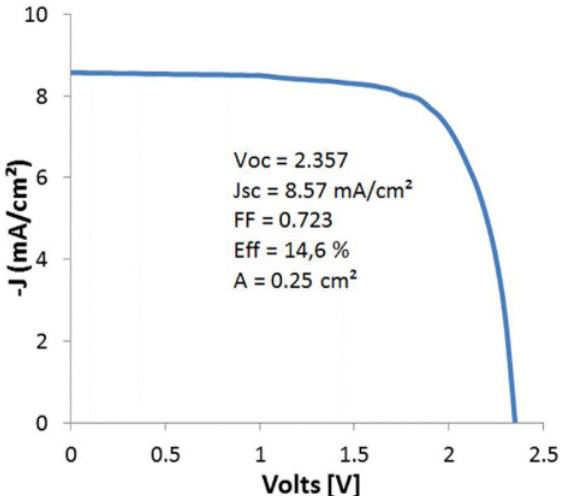
Fig. 3. Initial AM1.5 current-voltage (J-V) characteristics of triple-junction a-Si:H (a-Si:H/a-SiGe:H/a-SiGe:H) solar cell with 14.6% efficiency (adapted from [10]). Note: More recent cell records for the same technology reach up to 16